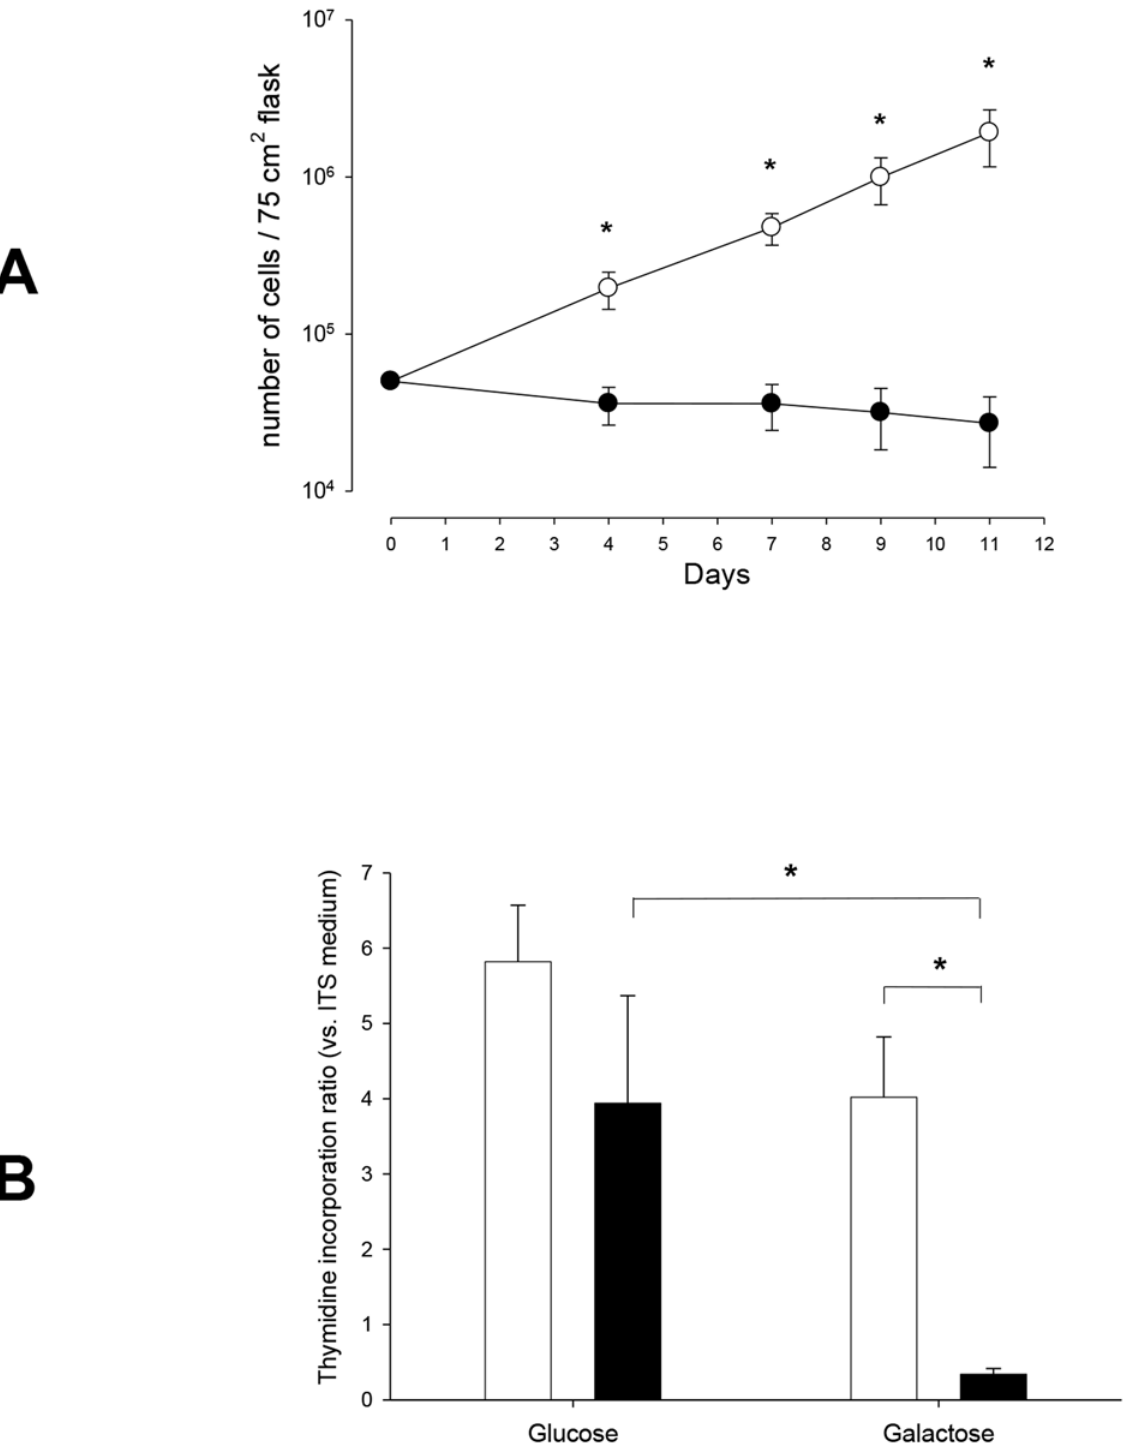
Fig 4. Effect of mitochondrial metabolism (aerobic glycolysis) on ASMC proliferation. A. Cell count according to the presence of glucose or not (galactose) in the culture medium. Results are means ± SEM. In galactose + 10% FCS medium, proliferation of neonatal ASMC (open circles, n = 6) is still present, unlike in adult ASMC (closed circles, n = 4). * p < 0 . 05 neonate vs. adult at the corresponding time using MANOVA. B. DNA synthesis according to the presence or absence of glucose in the culture medium. Values are means ± SEM. After 24h in a glucose-free (galactose) medium, neonatal ASMC (white bars, n = 5), DNA synthesis is still present, in contrast with adult ASMC (black bars, n = 3). * p < 0.05 using Mann-Whitney U-test.